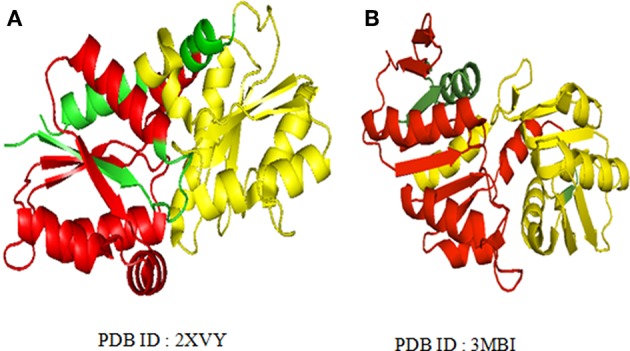
Varying larger repeat lengths are observed in the Rossmann fold of the (A) Cobalt chelatase CbiK (2xvyA) with repeat length 103 and (B) Phosphoribosyl pyrophosphate synthetase (3 mbiA) with repeat length 121. The repeats regions are highlighted with different colors.